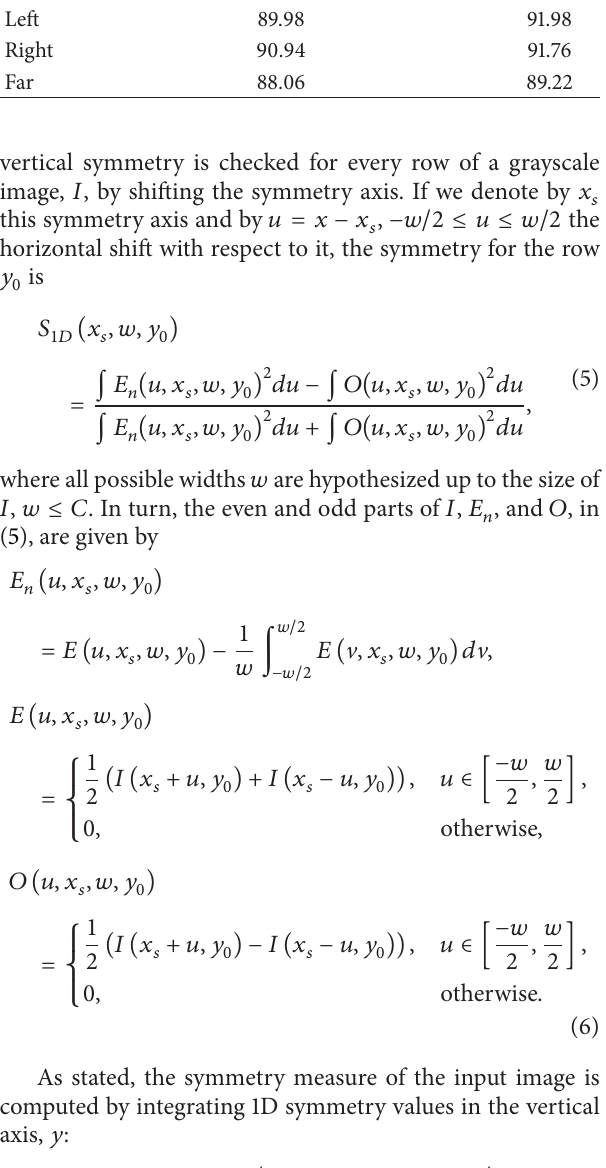
Table 3: Accuracy results of log-Gabor filters for the different image regions. Front Left Right Far Rate 𝐹 0 Rate 𝐹 0 Rate 𝐹 0 Rate 𝐹 0 Accuracy 98.00 1/2 97.36 1/3 97.06 2/5 91.60 1/3